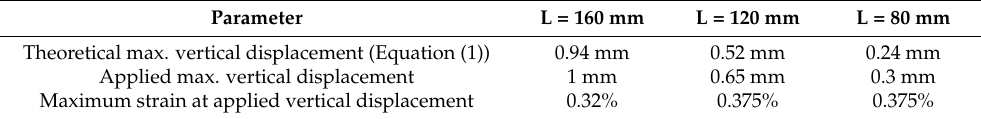
Table 2. Theoretical (calculated via Equation (1)) and applied maximum vertical displacement during the three point bending tests.